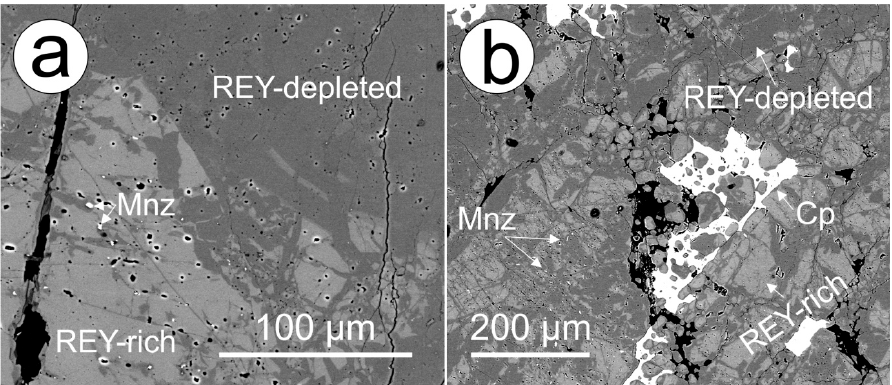
Figure 4. Back-scatter electron (BSE) images showing the textural and morphological character of early hydrothermal apatite from the magnetite-dominant mineralization (DM). ( a ) REY, Cl and S-rich zone (bright) adjacent to zones depleted in these elements (dark) related to fractures and associated with crystallization of monazite; ( b ) Extensive REY, Cl and S depletion in apatite associated with fracturing and the formation of monazite with late chalcopyrite infill. Abbreviations: Ap: apatite; Cp: chalcopyrite; Mnz: monazite.